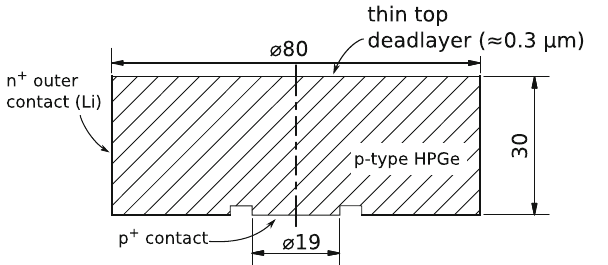
Fig. 1 Schematic drawing of the 50% relative efficiency BEGe detec- tor applied in the Ge-5 spectrometer and used in the presented study